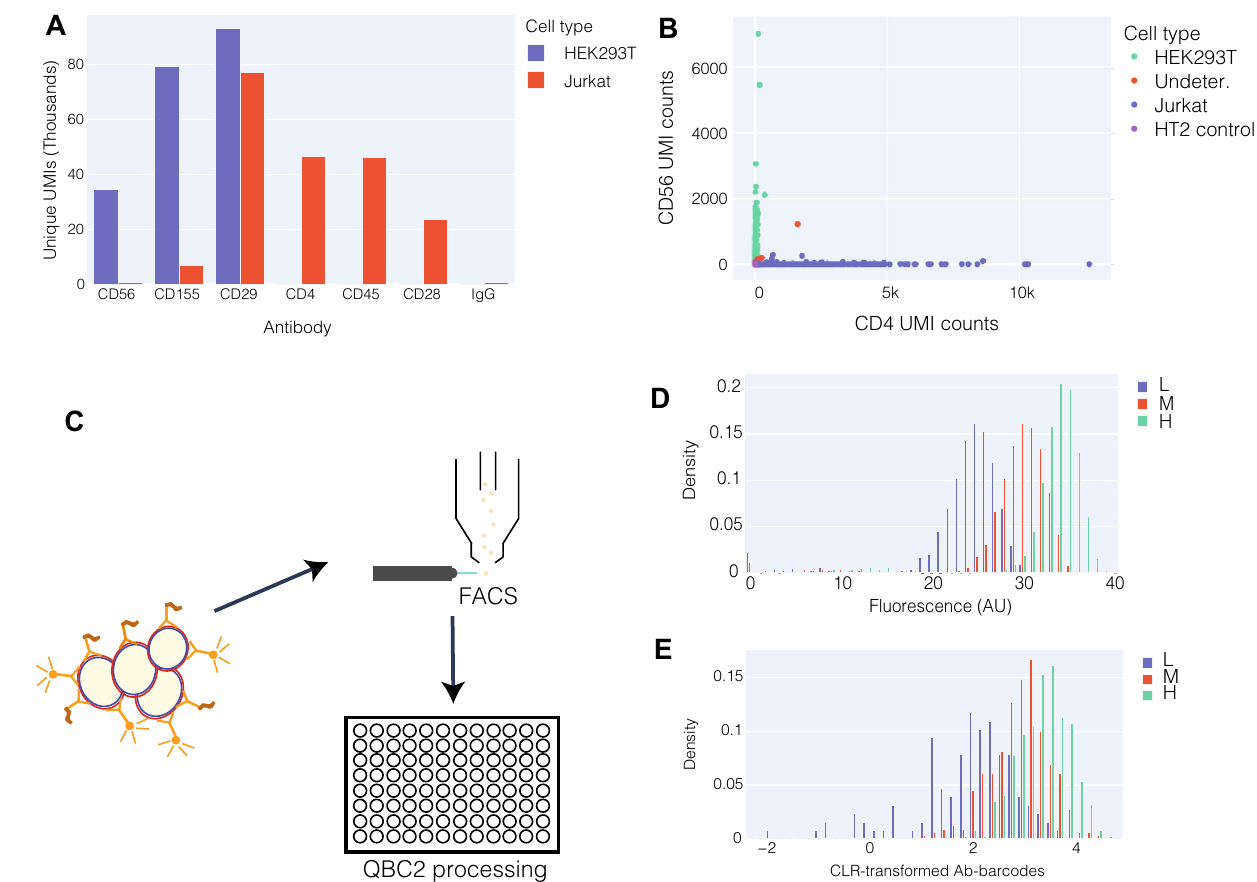
Figure 2. Benchmarking of QBC2 technology. ( A ) HEK293T and Jurkat cells were stained separately with an antibody cocktail containing the antibodies listed. Results from bulk sequencing of DNA-barcoded antibodies bound to stained cells are shown here. ( B ) In a two-cell line mixing experiment where HEK293T and Jurkat cells are used, antibody profiles were used to cluster the cells using k-means clustering (with k = 4) on the top 3 principal components to separate the distinct cell types. As CD56 and CD4 are seen in the bulk measurements to be unique to only one cell type, a visual representation of CD4 and CD56 counts on individual cells shows expression for only one or the other, as identified by clustering (Fig. S2C). HT2 control cells as expected did not stain for either CD56 or CD4. Out of a total of 1262 cells, only 11 were undetermined (0.9%). ( C ) Jurkat cells were co-stained with an antibody mix containing anti-CD4 DNA-barcoded antibody and anti-CD4-FITC. Cells were sorted by FACS for CD4 expression level and high, medium, and low populations were obtained. Sorted cells from the three populations were then uniquely labeled with different hashtag antibodies before collectively passing through QBC2 to quantify CD4 expression through sequencing of anti-CD4 DNA-barcoded antibodies. ( D ) CD4 expression levels are shown as determined by CD4-FITC antibody levels. ( E ) CD4 expression levels are shown as determined by CLR-transformed CD4 antibody-barcode